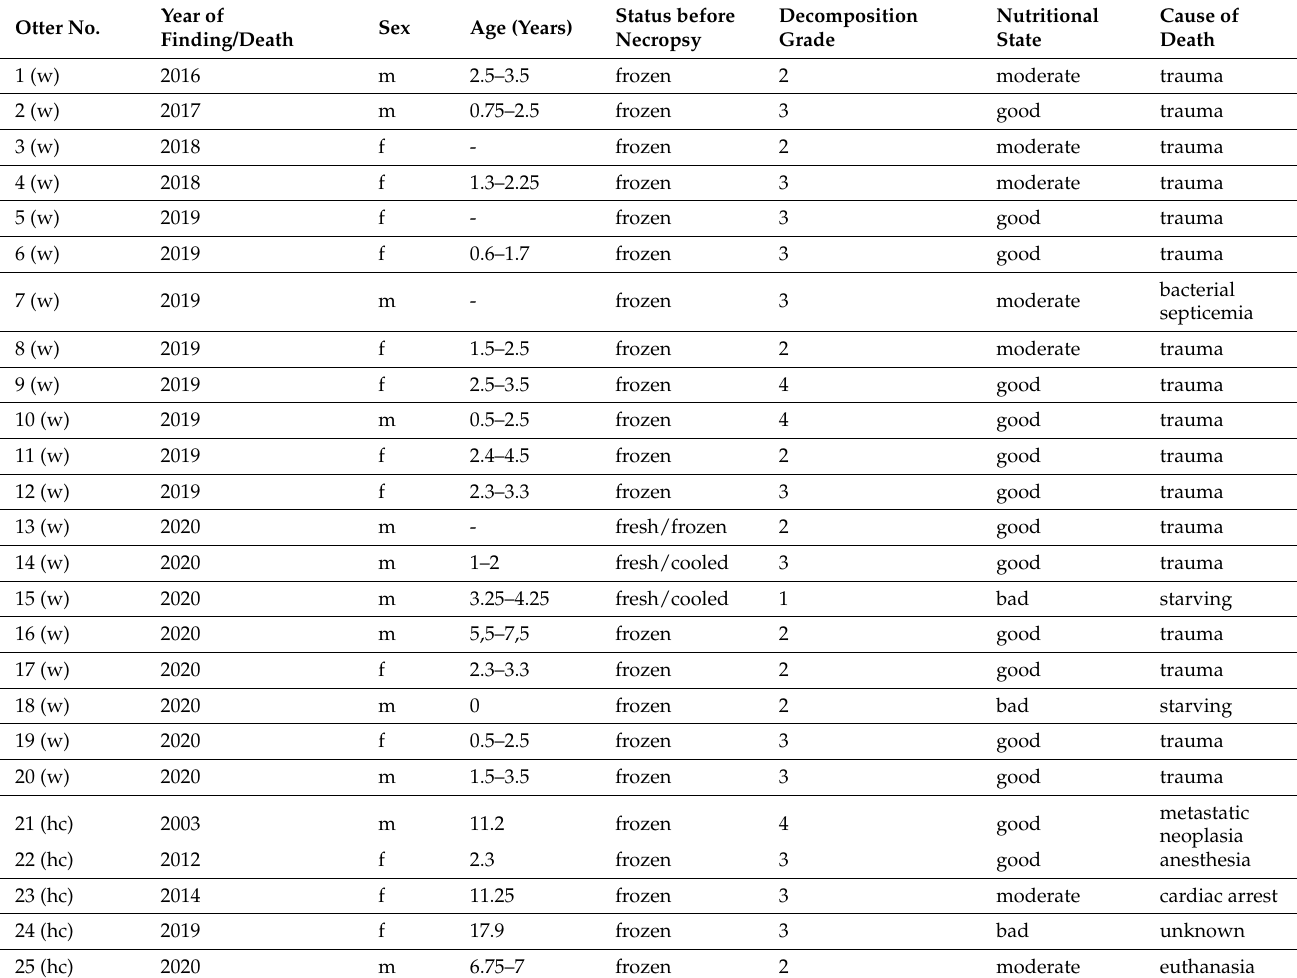
Table 1. Life history data and cause of death of all wild otters (w) from Schleswig-Holstein, Germany and five otters under human care (hc) used in the